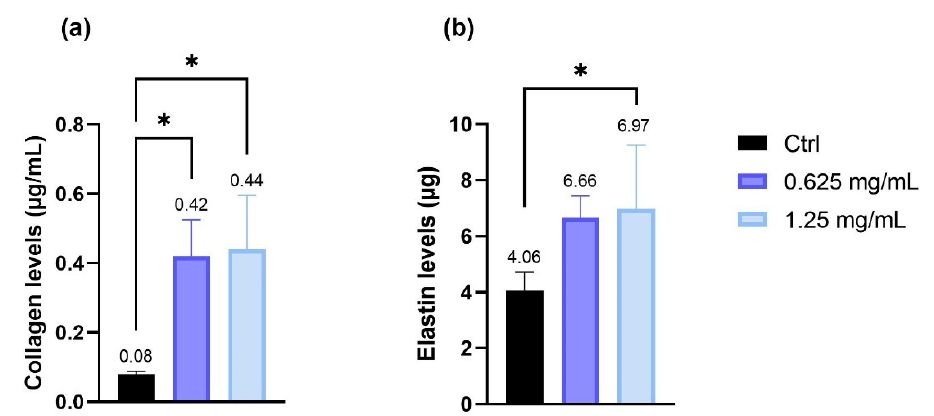
Figure 2. ( a ) Collagen levels and ( b ) elastin levels expressed as concentration (µg/mL) after treatment with the tested cream (0.625 and 1.25 mg/mL) in NHDF cells. * p values ≤ 0.05 were considered to be statistically significant compared with untreated cells ( n = 3; replicates = 2).